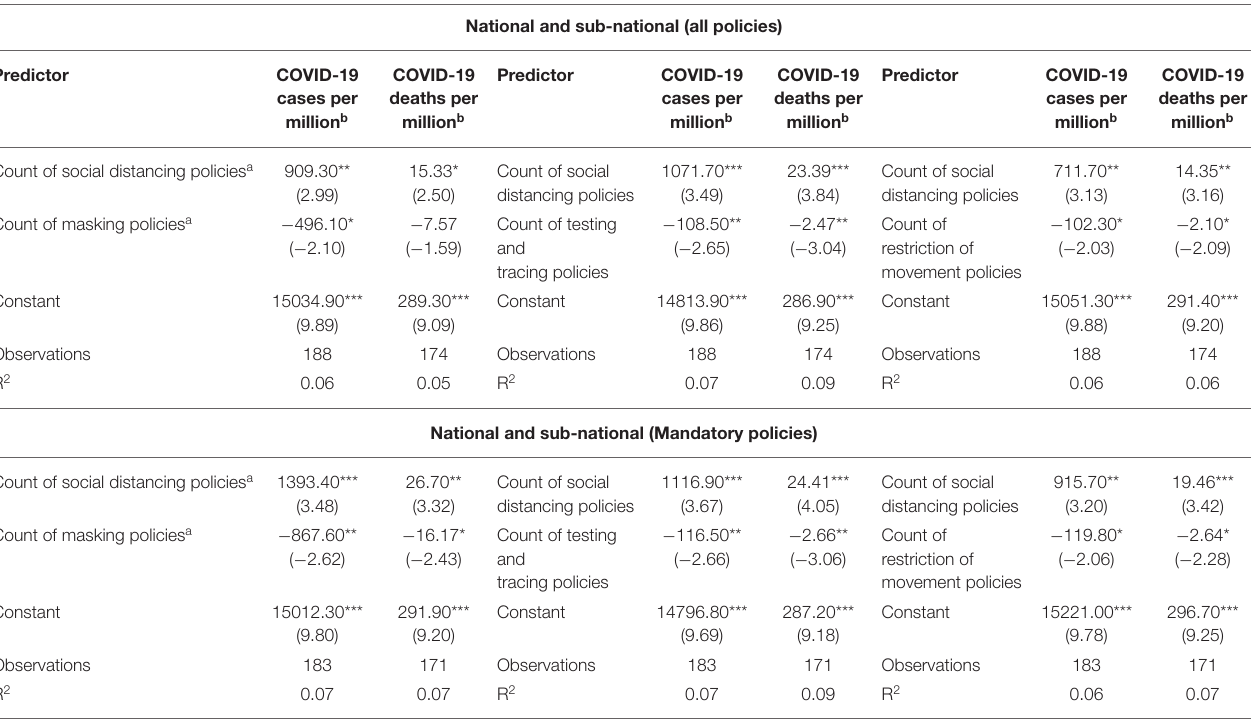
TABLE 4 | Multivariate regression for associations between select policies and COVID-19 health